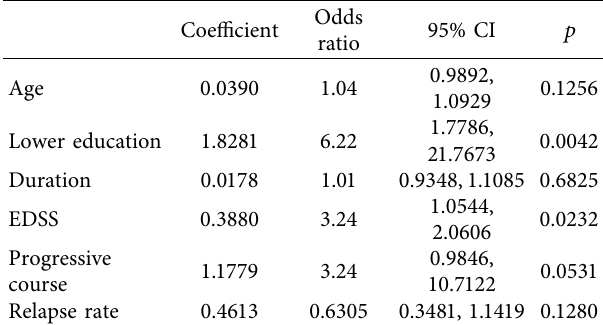
Table 7: Logistic regression analysis for various factors predicting CI in patients with